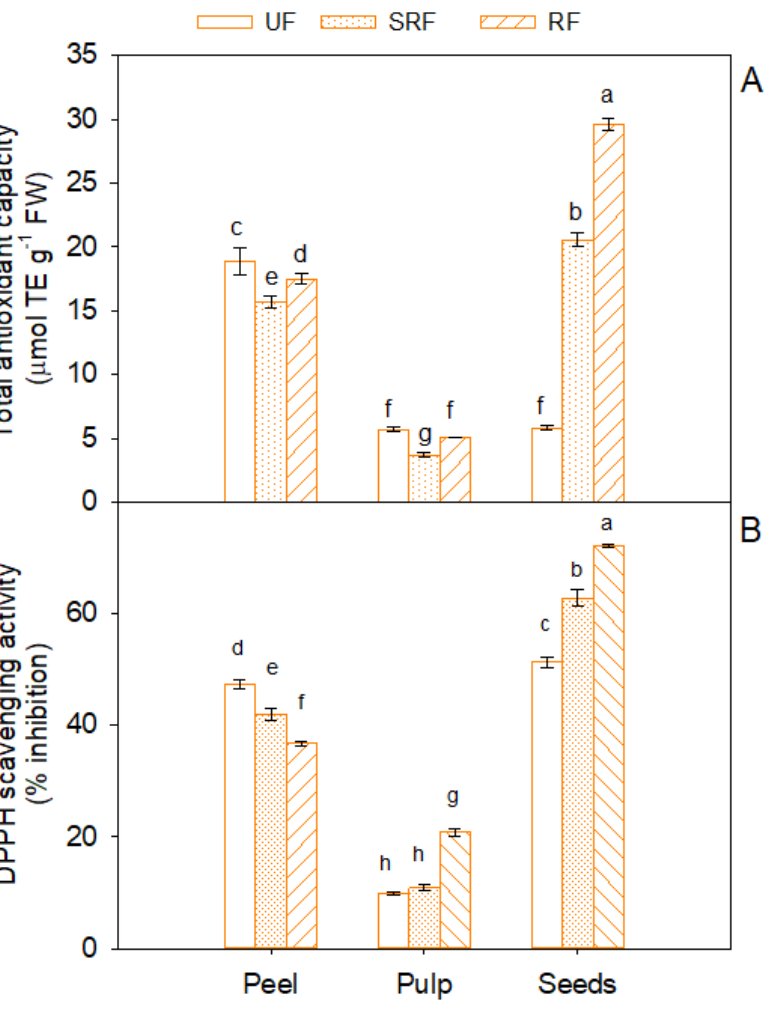
Figure 3. Total soluble antioxidant capacity ( A ) and DPPH (1,1-diphenyl-2-picrylhydrazyl) scav- enging activity ( B ) in peel, pulp, and seeds of unripe (UF), semi-ripe (SRF) and ripe fruits (RF), of Phlegrean mandarin. Each bar represents the mean ± SE ( n = 8). Different letters indicate significant differences ( p < 0.05), according to Duncan’s post-hoc test. TE: Trolox equivalents; FW: fresh weight.